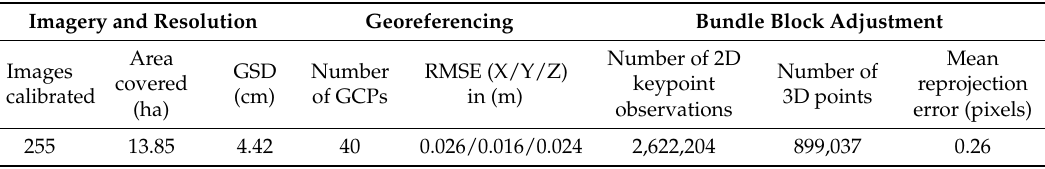
Figure 3. Orthorectified image mosaic of the small study site (31 October 2015). Darker areas within the gully system are withered vegetation. The main gully in the northern section is Gully-4, as mentioned above. Table 4. Summary of the outputs obtained in